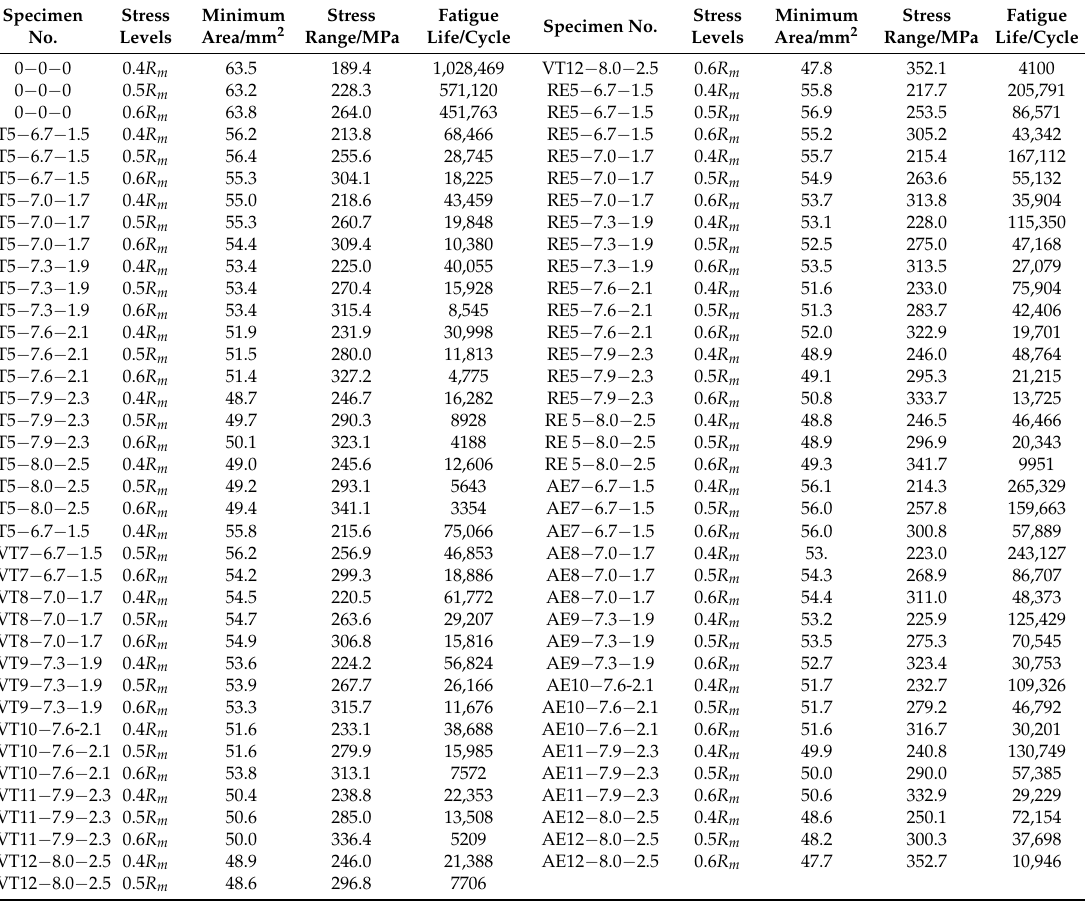
Table 3. Experimental results of fatigue